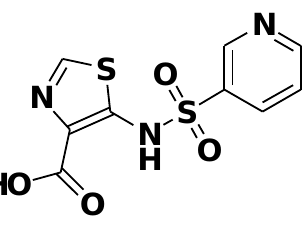
Figure 6. Structure of ANT-431 (C 9 H 7 N 3 O 4 S 2 , MW = 285.3), IUPAC name 5-(pyridin-3-ylsulfonylamino)-1,3-thiazole-4-carboxylic acid. The chemical structure was drawn using the ChemDraw Ultra 7.0 software (Chem Office 2002).